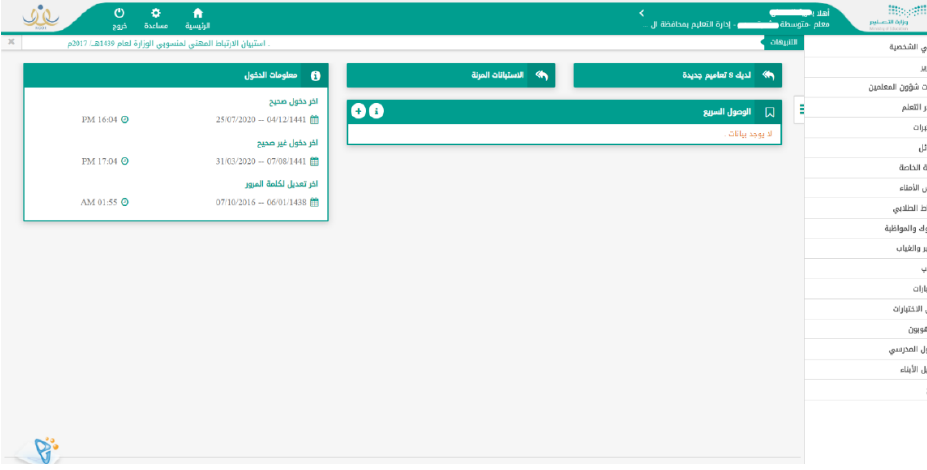
Figure 2. Noor homepage. Figure 2. Noor